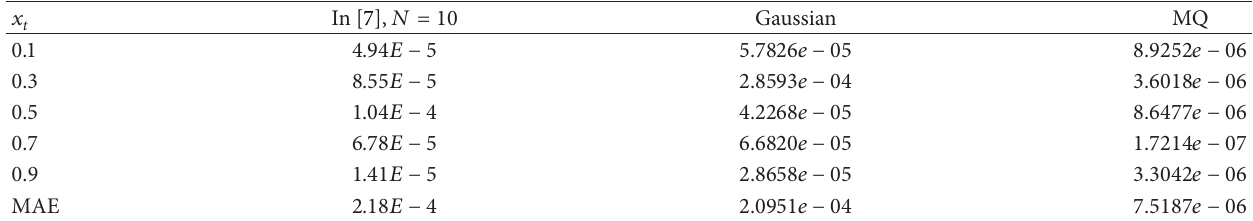
Table 1: The absolute error of the Sinc-collocation method, Gaussian method, and MQ RBF method.